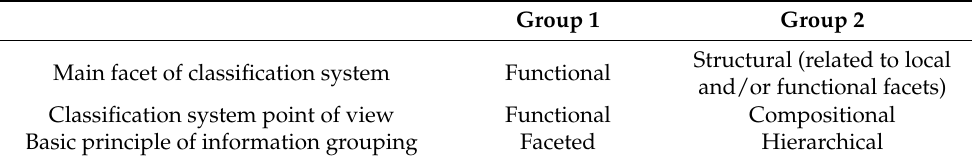
Table 1. Assignment of comparable construction information of global classification systems when evaluating classification results. Group 1 Group 2 Structural (related to local Main facet of classification system Functional and/or functional facets) Classification system point of view Functional Compositional Basic principle of information grouping Faceted